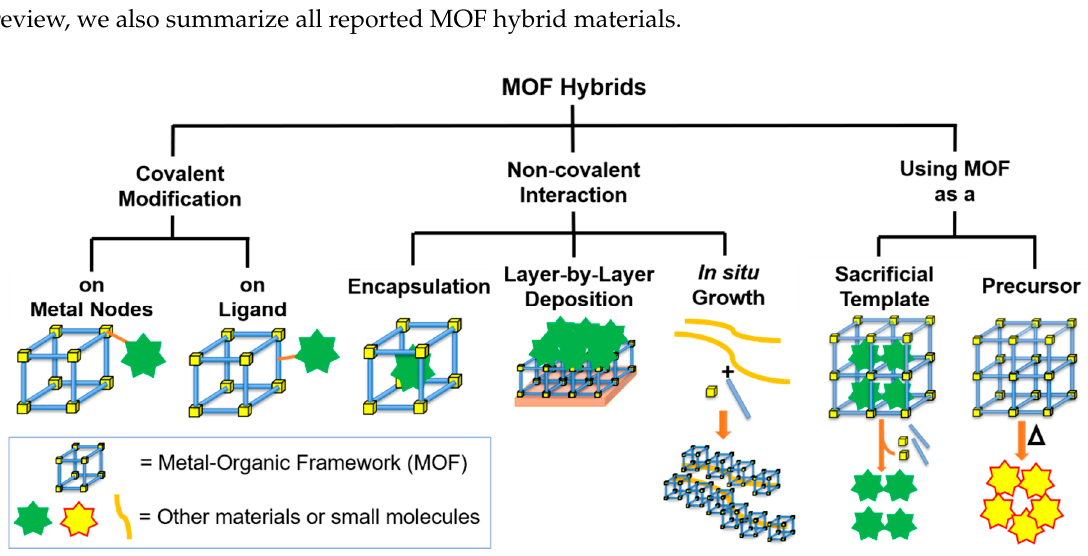
Figure 1. MOF (metal ‐ organic framework) hybrid preparation methods discussed in this review.